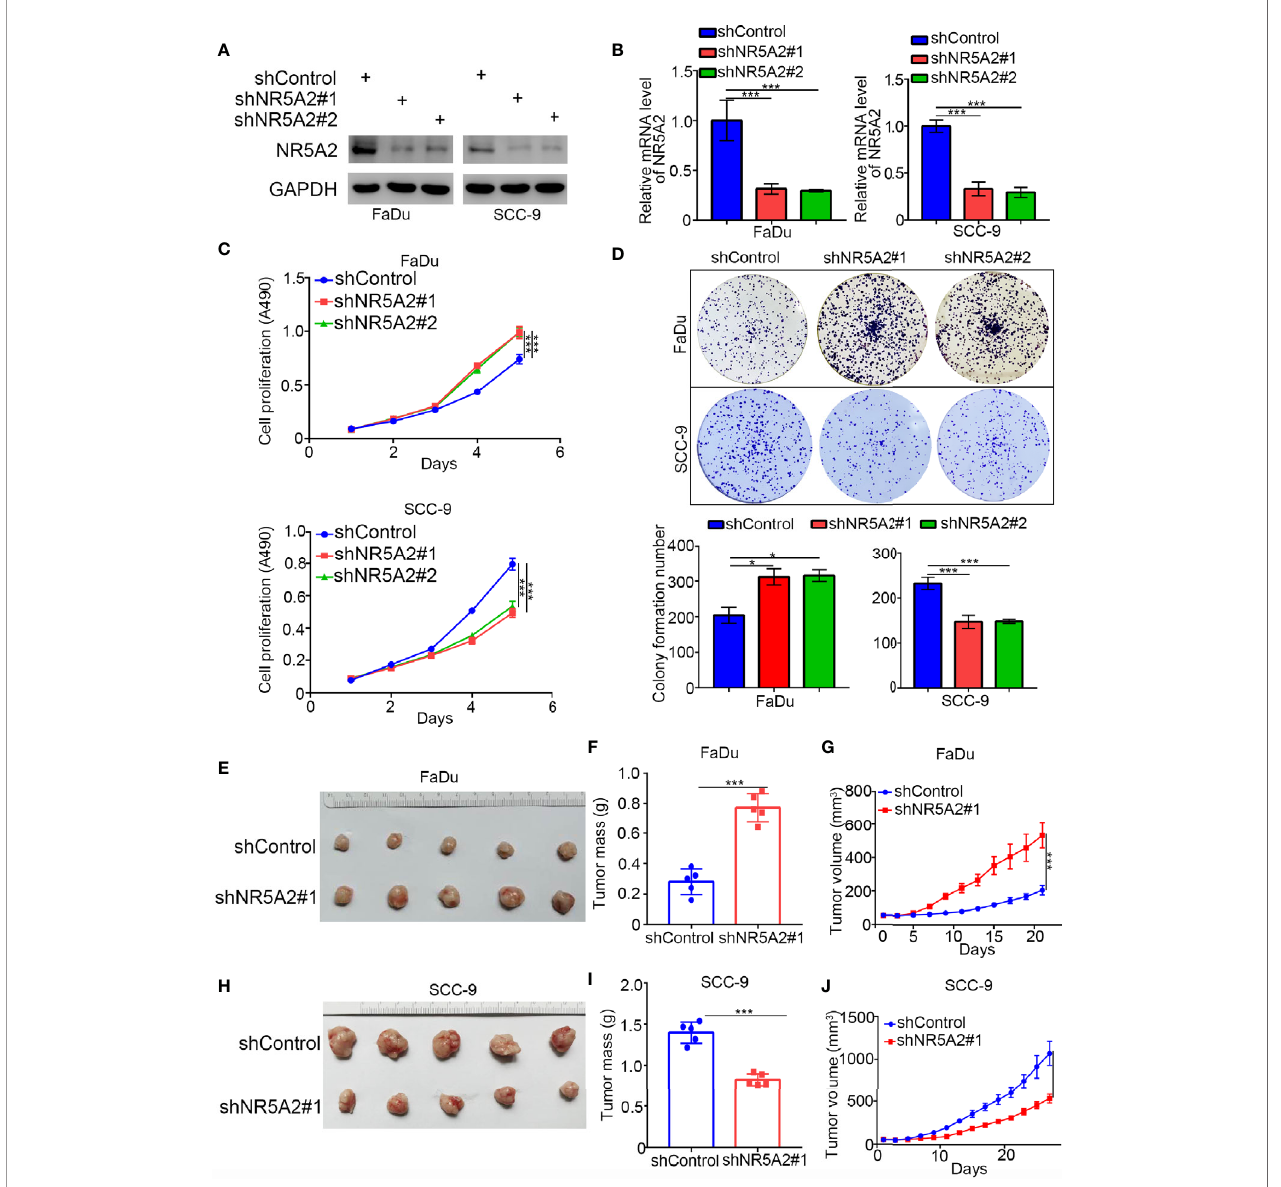
FIGURE 5 | Role of NR5A2 in cell proliferation in different HNSCC cell lines. (A, B) Western blot analysis (A) and RT-qPCR (B) of NR5A2 expression in FaDu and SCC-9cells treated with indicated shRNAs. Data presented as the mean ± SD of three independent experiments. ***p < 0.001. (C, D) FaDu and SCC-9 cells infected with lentivirus vectors expressing control or NR5A2 speci fi c shRNAs were harvested for MTS assay (n = 5), colony formation assay (D) . The photo was taken on the 14th day after 500 cells seeded, each bar represents the mean ± SD of three independent experiments. *P < 0.05; ***P < 0.001. (E, G) FaDu cells infected with shcontrol or shNR5A2 were injected subcutaneously into the right dorsal fl ank of nude mice. The tumor volume was measured every three days (G) . Then the tumors were harvested, photographed (E) and weighed (F) . The data are presented as the means ± SD (n = 5). ***P < 0.001. (H, J) SCC-9cells infected with shcontrol or shNR5A2 were injected subcutaneously into the right dorsal fl ank of nude mice. The tumor volume was measured every three days (J) . Then the tumors were harvested, photographed (H) and weighed (I) . The data are presented as the means ± SD (n = 5). ***P <